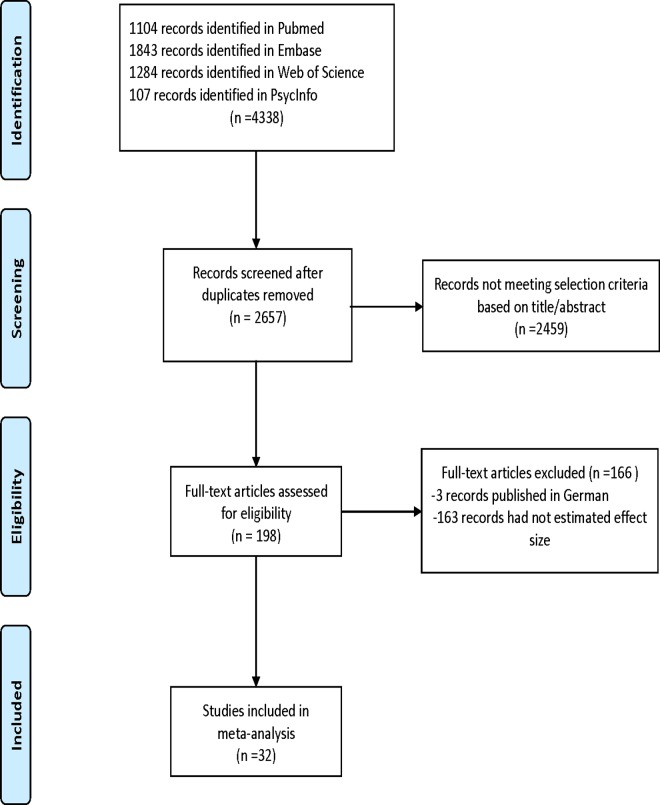
Flow of study selection.